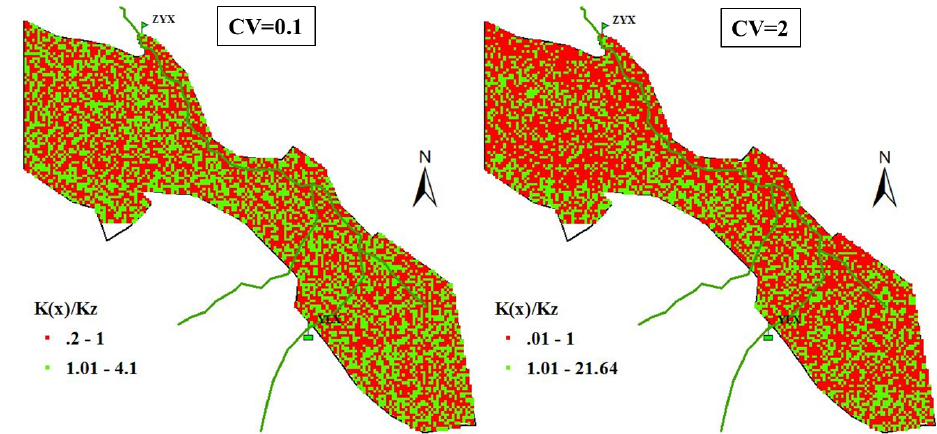
Figure 4. Grid-scale realization of K field perturbation when CV equals 0.1 and